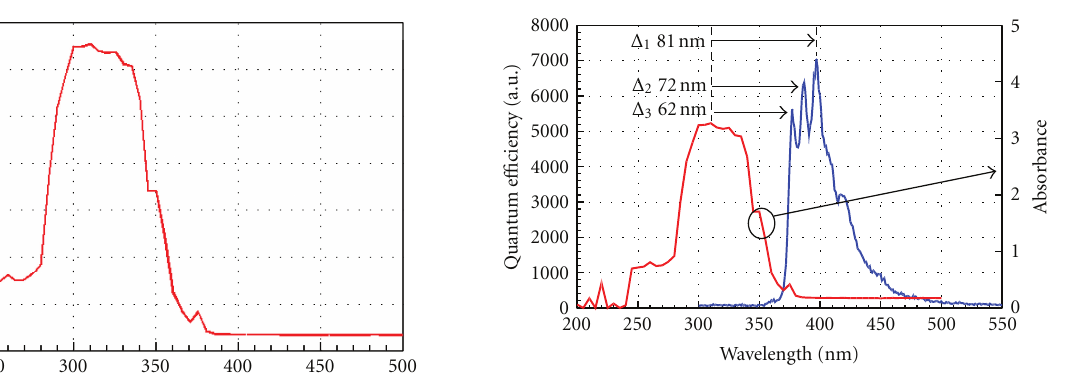
Figure 5: Stokes’ shifts of 1,2 :3,4-dibenzanthracene in ethanol. emission spectra are shown on the same graph in Figure